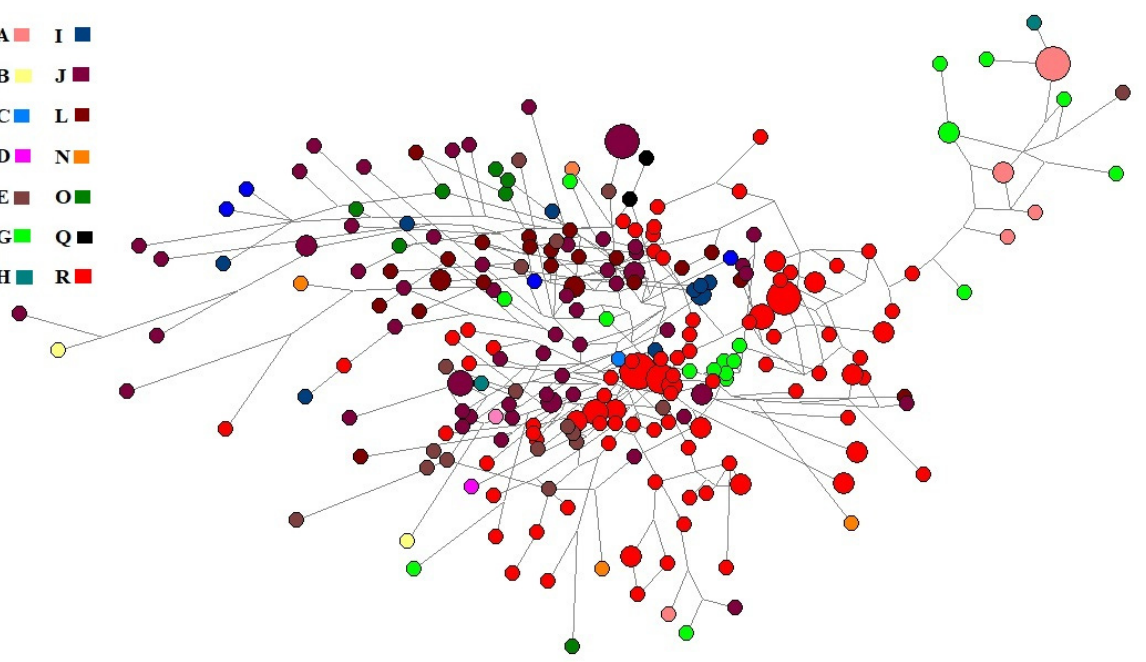
Figure 2. The median-joining network of the Roma population of